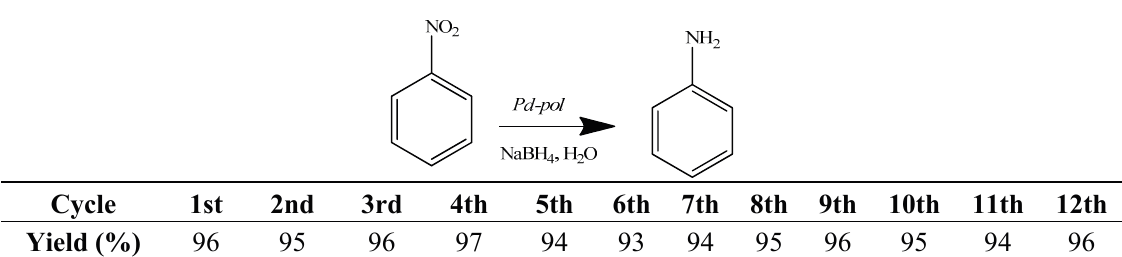
Table 2. Transfer hydrogenation of nitrobenzene over twelve cycles a .